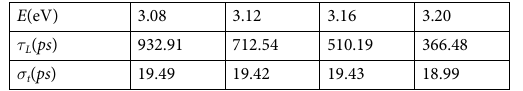
Table 1. Parameters for the solid curves in Fig. 4.